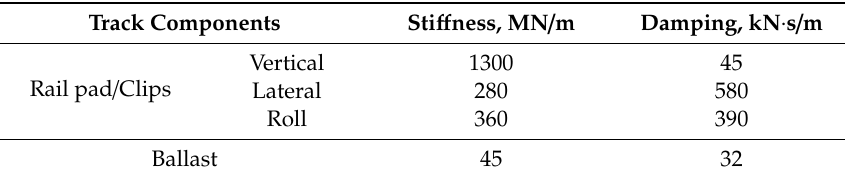
Table 3. Track parameters applied in the MBS model.